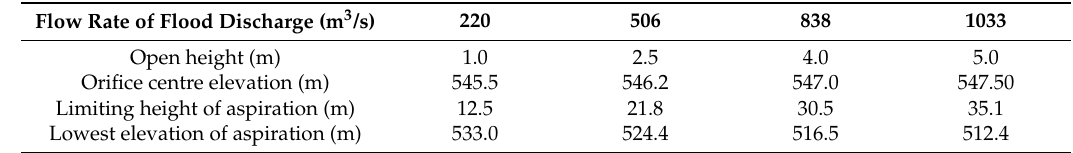
Table 5. Limiting height of aspiration for different flow rates of flood